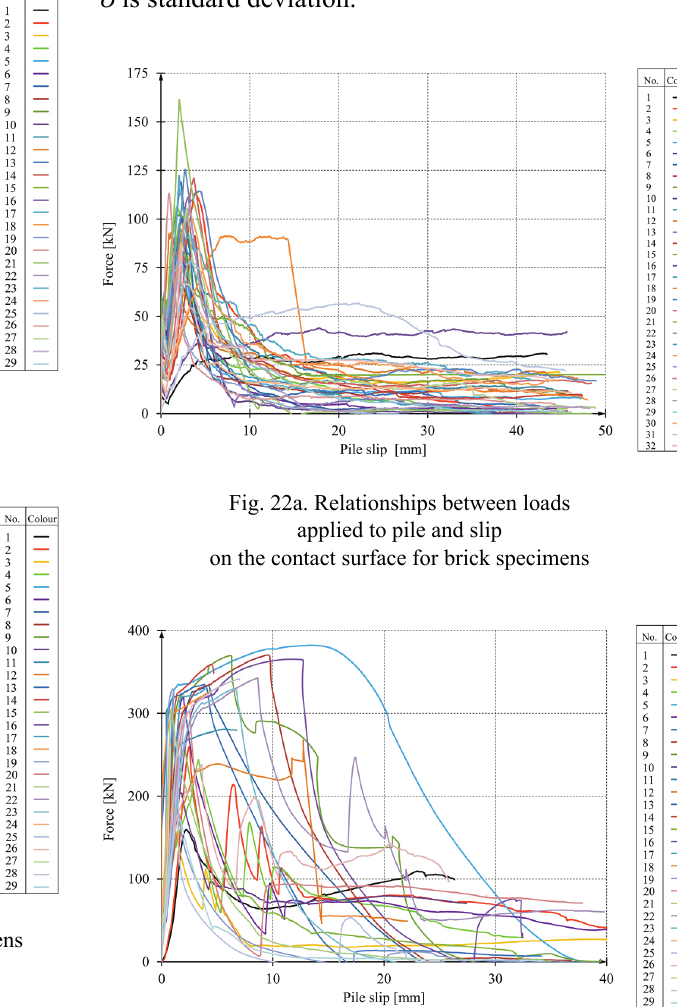
Fig. 22b. Relationships between forces applied to pile and slip on a contact surface in concrete specimens